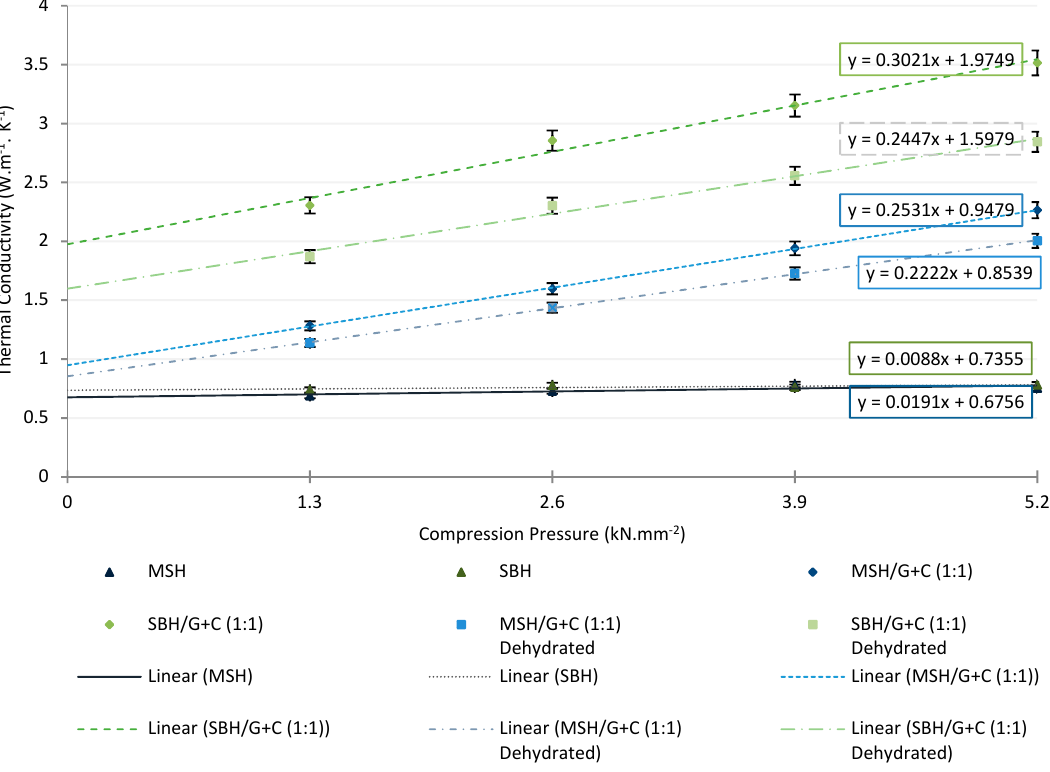
Figure 30. Thermal conductivity test results for the pellets manufactured at the different compressing pressures. The samples that were dried completely before the tests are marked with dehydrated at the end of their name.